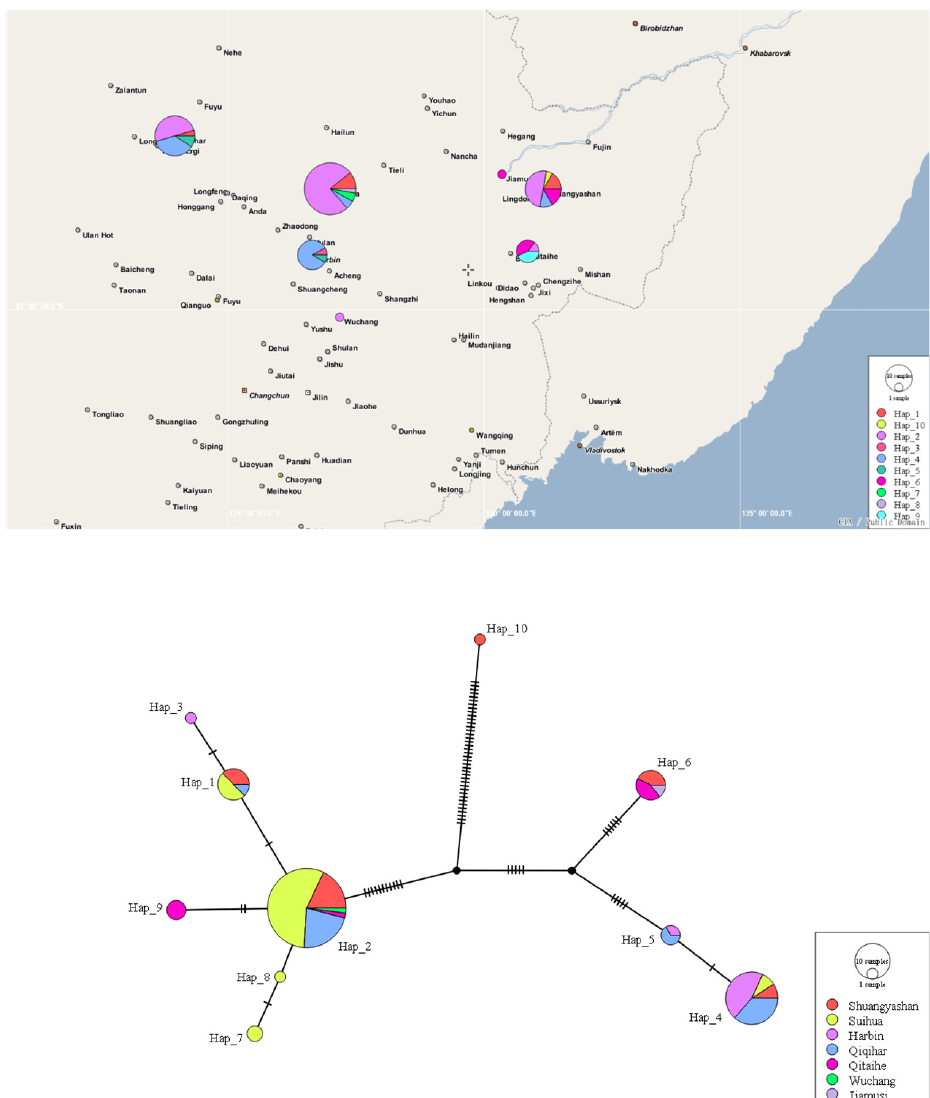
Figure 6. Haplotype distribution and TCS analyses based on the concatenated sequences of ITS and TEF-1 α genes of 99 FFSC isolates obtained from different locations of Heilongjiang province, China. Each haplotype is represented by a circle, the size of which is proportional to the haplotype frequency.